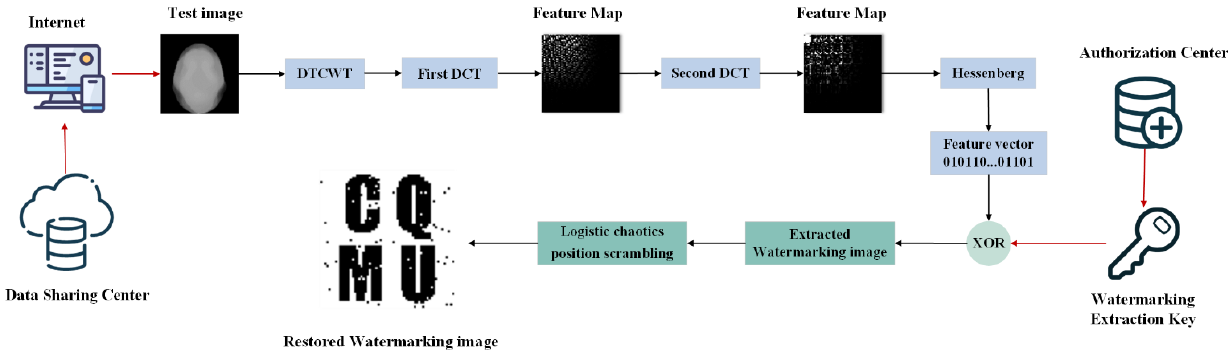
Figure 5. Watermarking-extraction flowchart.